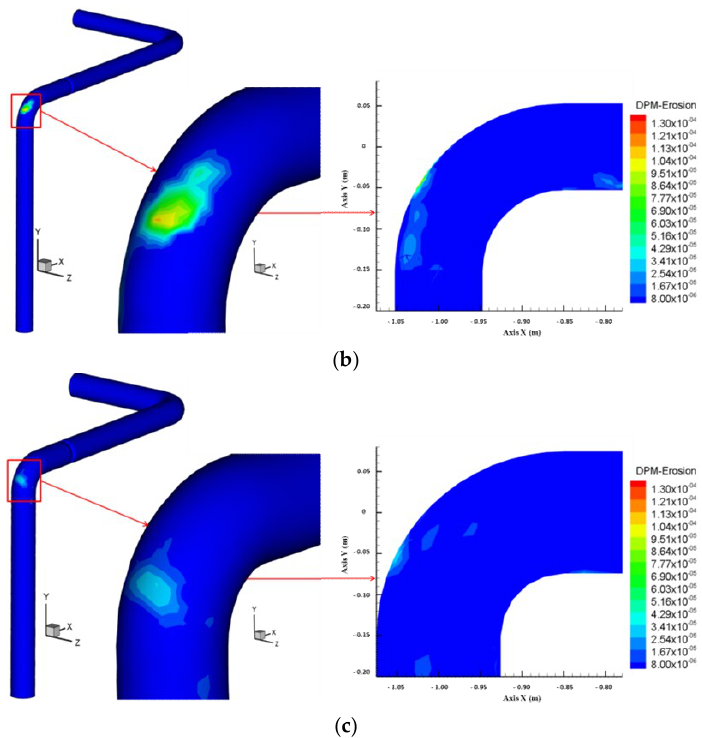
Figure 12. Erosion rate contours of gas–solid two-phase flow pipeline for different pipe diameters with 20% of the throttle valve opening. ( a ) DN80; ( b ) DN100; ( c ) DN150.